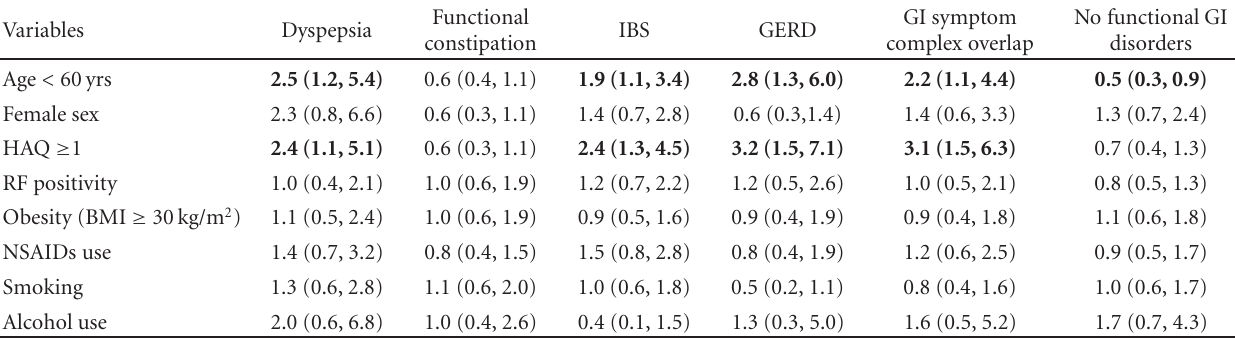
Table 4: Multivariable models of variables # associated with GI syndromes in RA